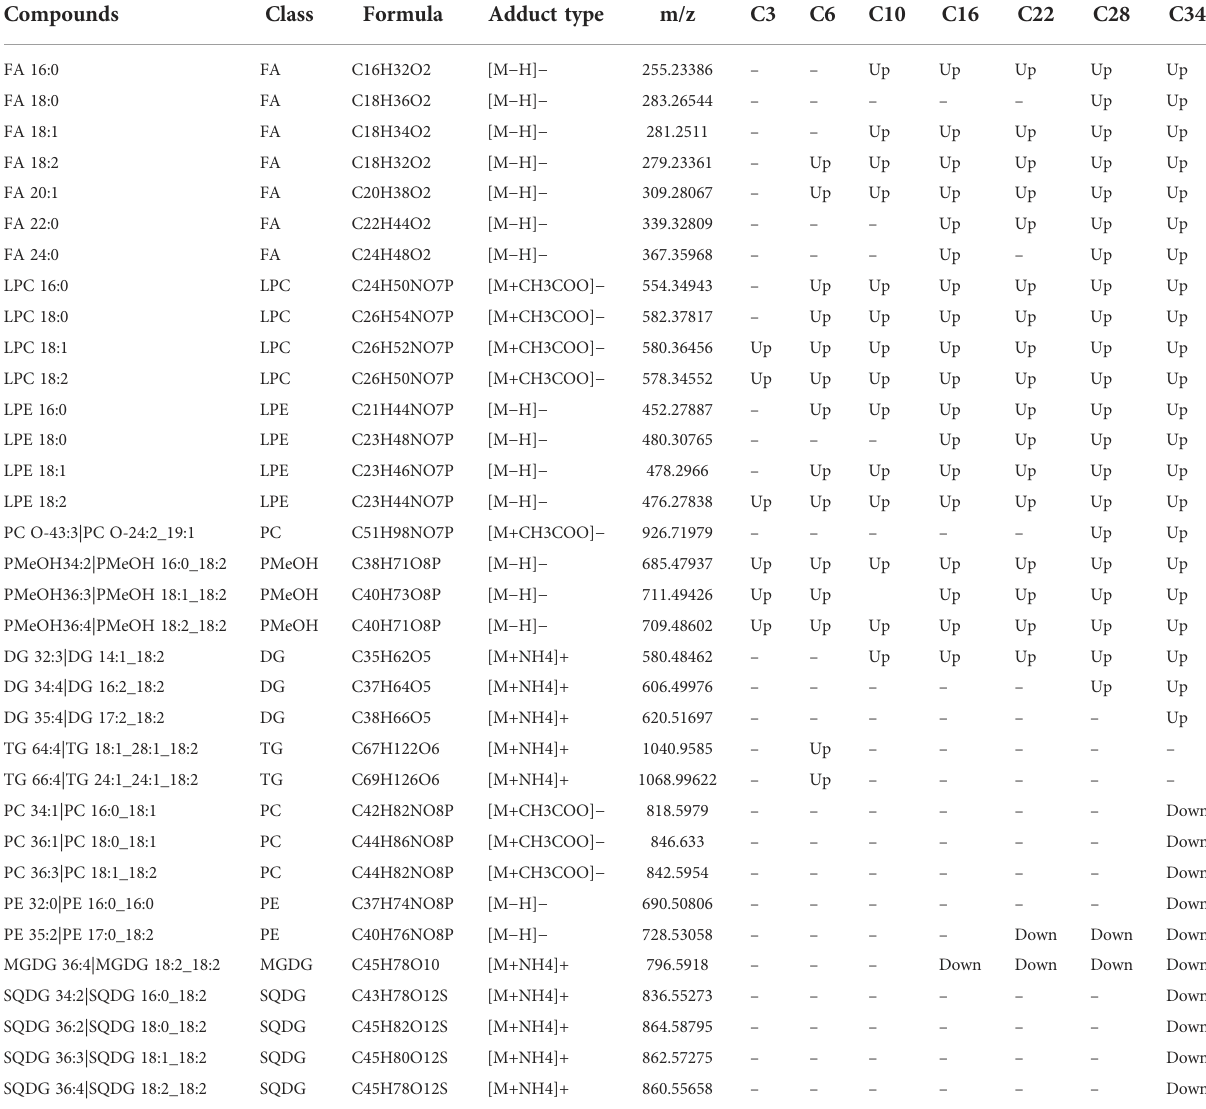
TABLE 2 Screening list of lipid differential metabolites. Compounds Class Formula Adduct